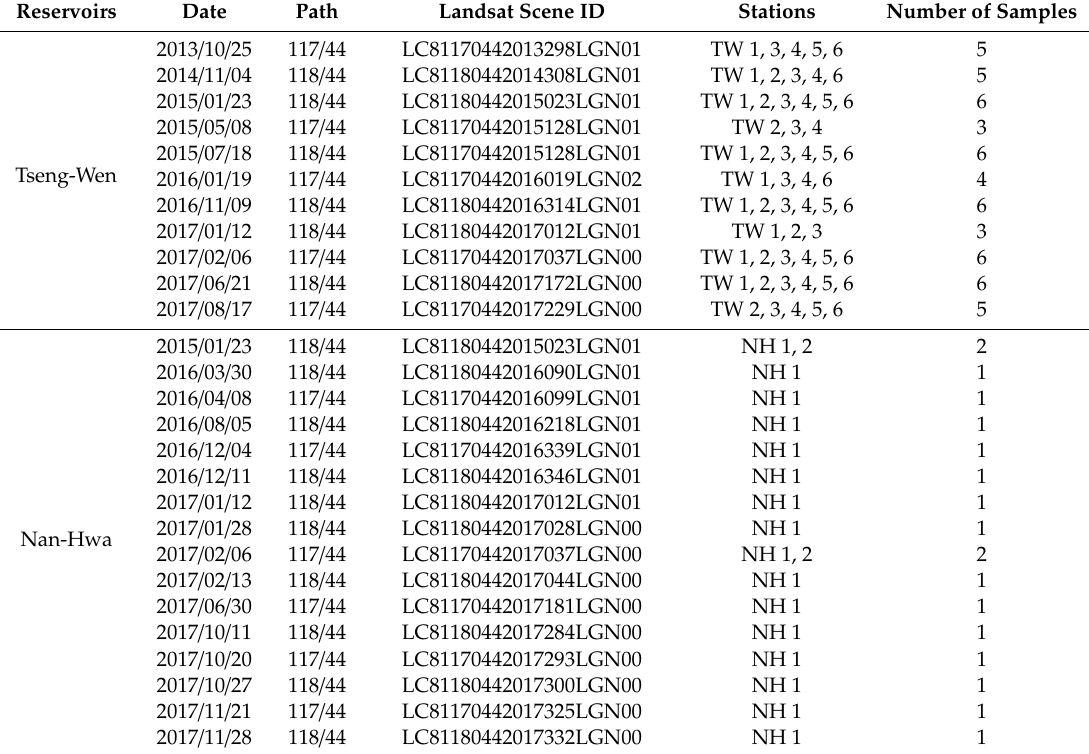
Table 3. The information on selected Landsat 8 satellite imagery.